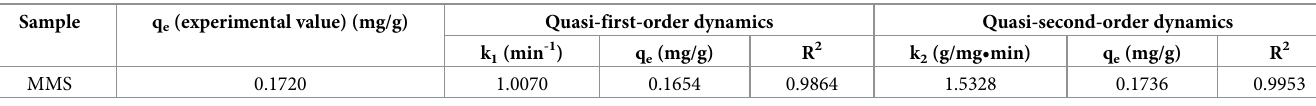
Table 5. The parameters of kinetic models. Sample q e (experimental value) (mg/g) Quasi-first-order dynamics Quasi-second-order